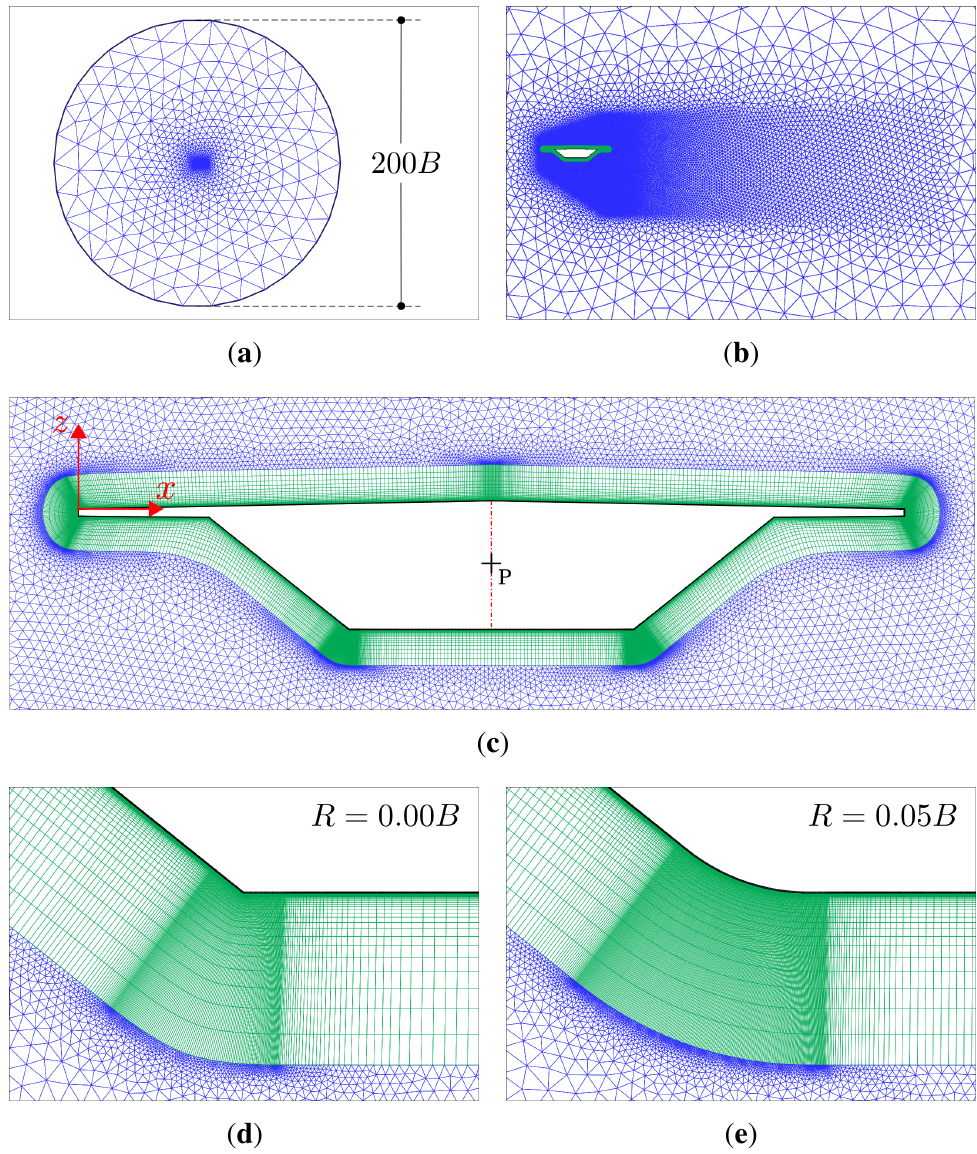
Figure 18. Computational grids for the bridge section: computational domain ( a ); wake refinement ( b ); near body mesh ( c ); close-up of the upstream lower corner for the sharp-edge configuration ( d ) and for a smooth-edge configuration ( e